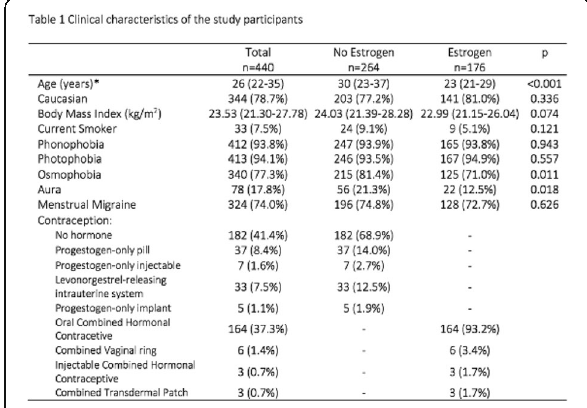
Table 1 (abstract P049). See text for